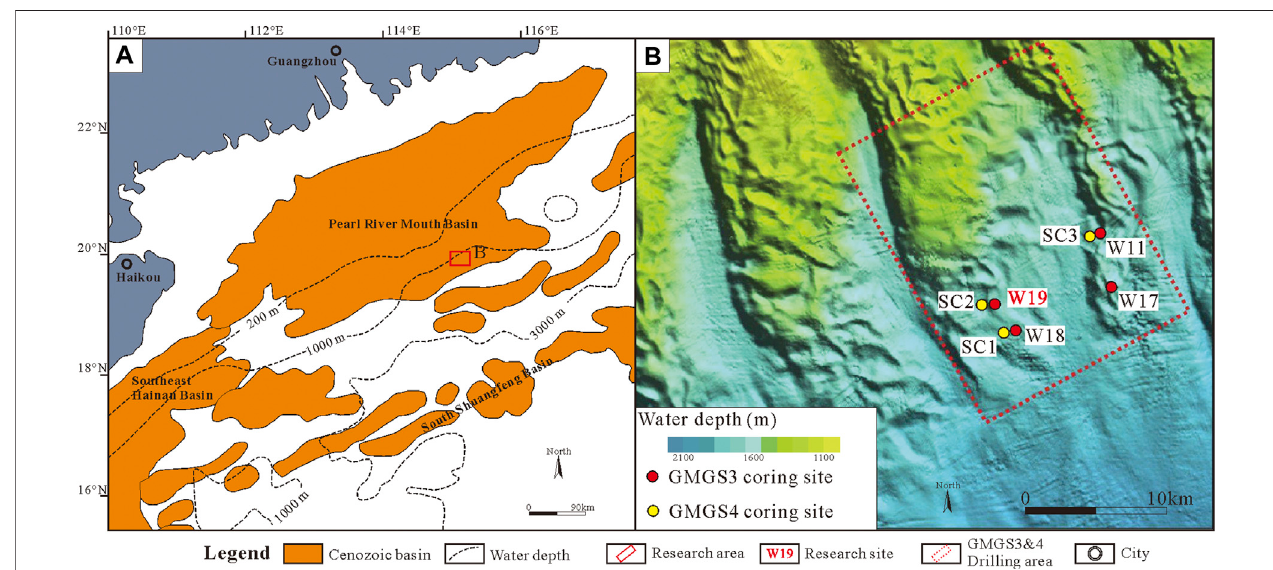
FIGURE 1 | The geological map of study area. (A) the geological map of northern slope of SCS, modi fi ed from Li et al. (2019); (B) enlarge the red box in fi gure (A) , the drilling area of GMGS3&4, modi fi ed from Zhang W. et al. (2019).